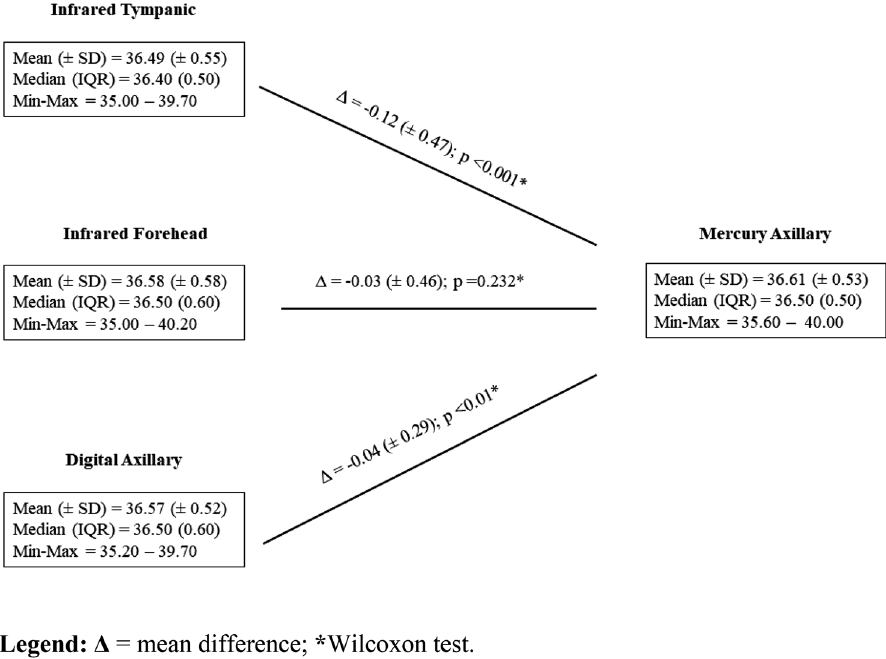
Figure 1. Paired comparisons between the axillary mercury thermometer and the alternative ones (Measurements = 711). Δ = mean difference; * Wilcoxon test.